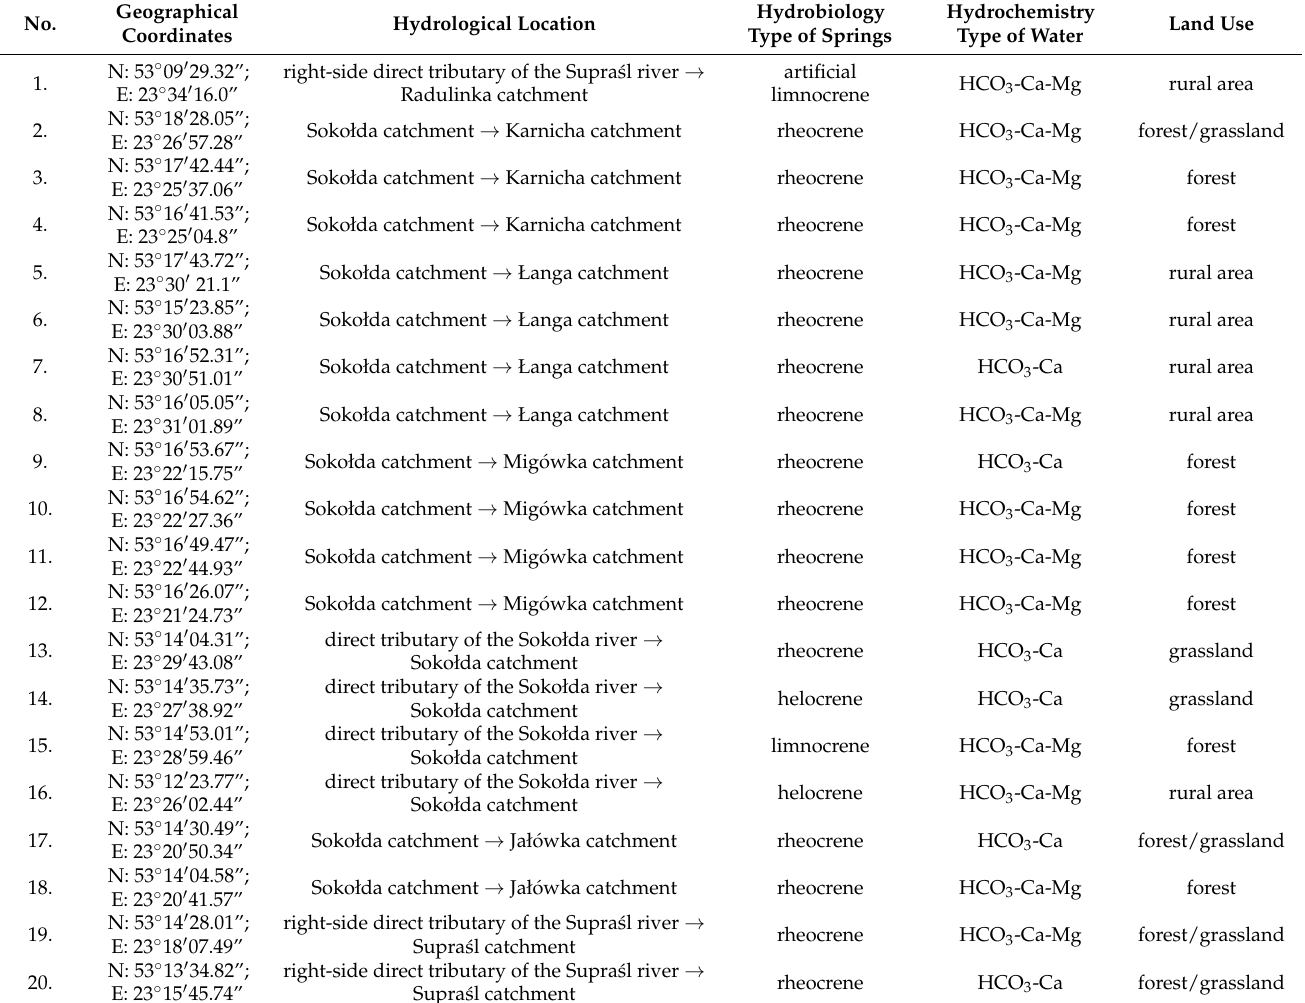
Table 1. Characteristics of the springs in the Knyszyn